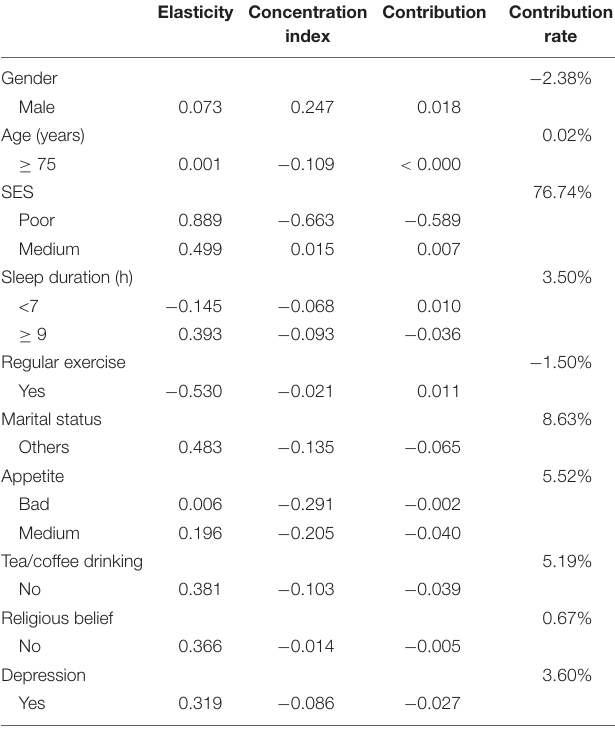
TABLE 5 | Decomposition analysis on the inequality of cognitive